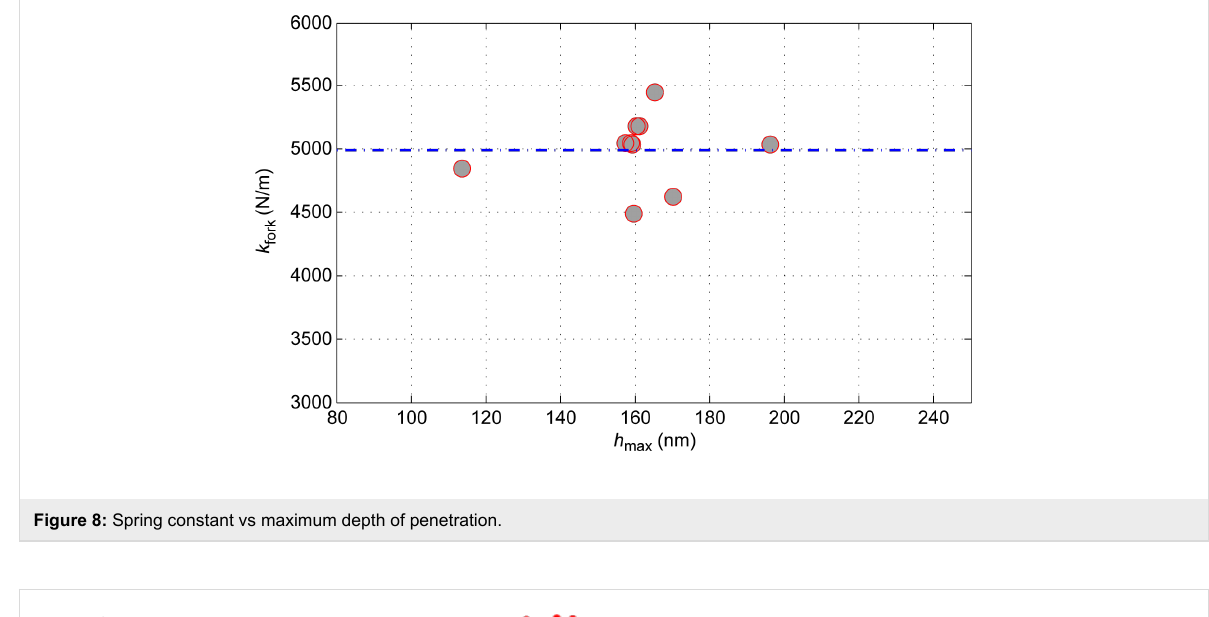
Figure 8: Spring constant vs maximum depth of penetration.